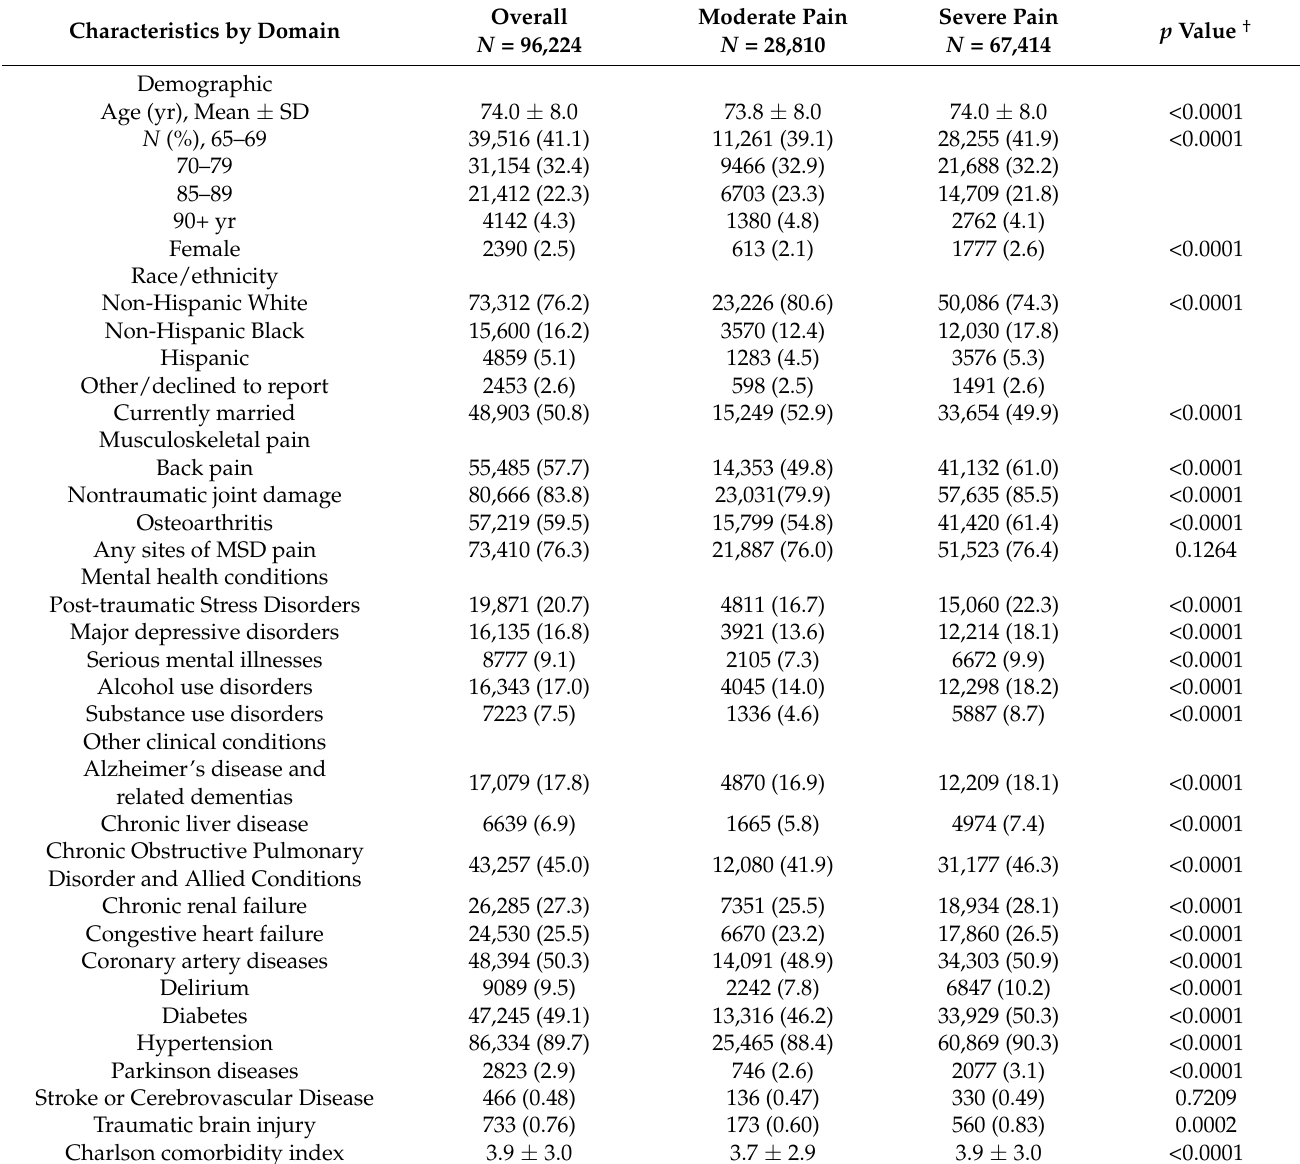
Table 1. Characteristics of US veterans with chronic pain prior to hospital admission during fiscal year 2013: in overall sample and according to pain intensity * ( N =